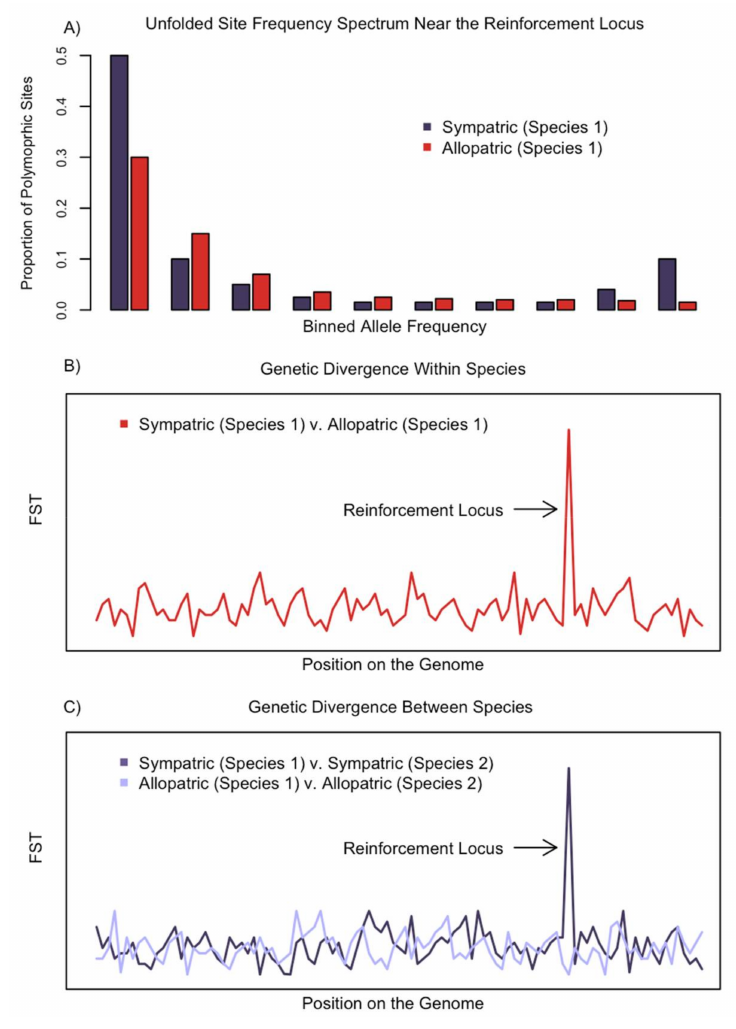
Figure 2. Hypothetical examples of three genomic signatures that may result from the evolution of reinforcement. ( a ) Reinforcement can cause a signature of a selective sweep in sympatry, distorting the site frequency spectrum near the reinforcement locus. In sympatric populations, there will be an excess of fixed and rare alleles compared to allopatric populations. ( b ) Trait divergence in sympatric populations can cause increased genetic divergence around the reinforcement locus between allopatric and sympatric populations of the same species. Both an increase in absolute divergence between allopatric and sympatric populations and a decrease in diversity within sympatric populations can cause elevated F ST near reinforcement loci. ( c ) Reinforcement only selects for divergence between hybridizing sympatric species and not their allopatric counterparts. This pattern can cause greater divergence (F ST ) between sympatric populations of the two species compared to allopatric populations of the two species at the reinforcement locus. Increased F ST could be caused by both greater divergence between sympatric alleles and less allelic diversity within a sympatric